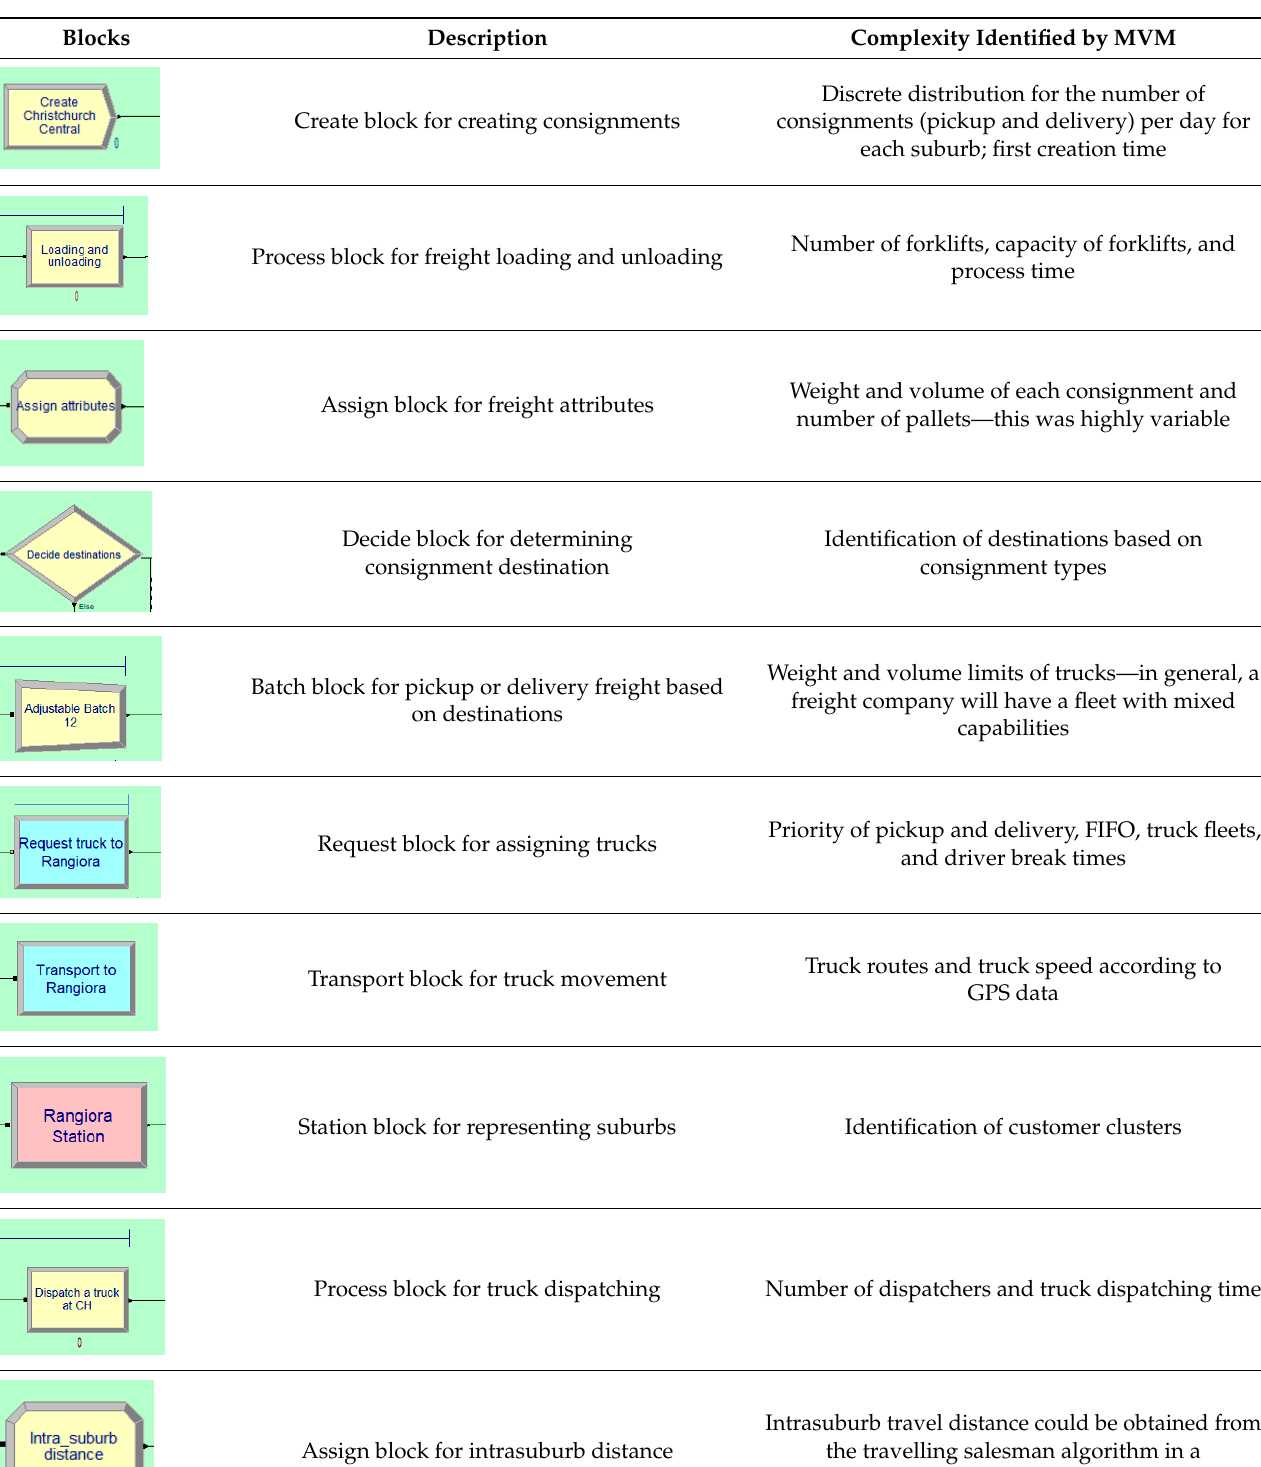
Figure 12. Refined architecture of Arena model with blocks defined in Table 5. ( a ) Example of one suburb PUD; ( b ) depot operations. Table 5. Complexity of main Arena blocks for the detailed Table 5. Complexity of main Arena blocks for the detailed model.